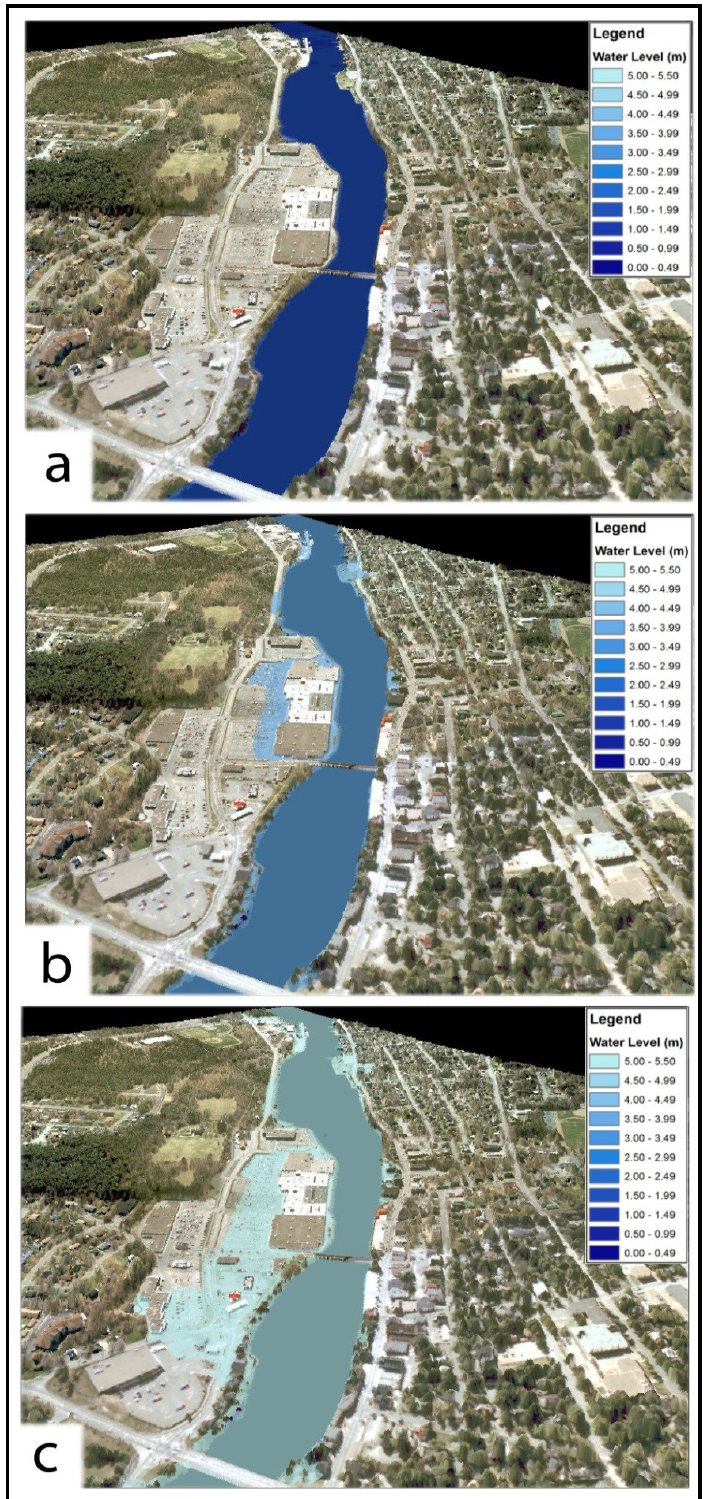
Figure 10. A comparison of perspective views of the flood risk extents for various hydrodynamic models outputs. Each view is centered on the Bridgewater mall and looking down stream of the LaHave River with the 50 year return period discharge at 99.5% probability (441 m 3 /sec). Simulated high water levels include; ( a ) Normal water level HD model, ( b ) Normal tide + 2.2 m storm surge HD model, and ( c ) Normal tide + 3.5 m storm surge HD